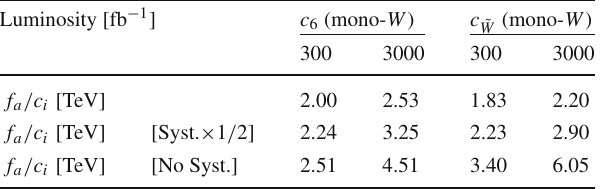
Table5 Projected95% CL f a / c i LHCreachfor (cid:17) = e finalstates,with L = 300 fb − 1 and L = 3000 fb − 1 for the effective operators relevant to mono- W production, as detailed in Sect. 6.3.1. Top row: Assuming future systematic uncertainties on the background scale as present ones. Middle row: Assuming systematic uncertainties are reduced by a factor 2 w.r.t. present ones. Bottom row: Assuming no background